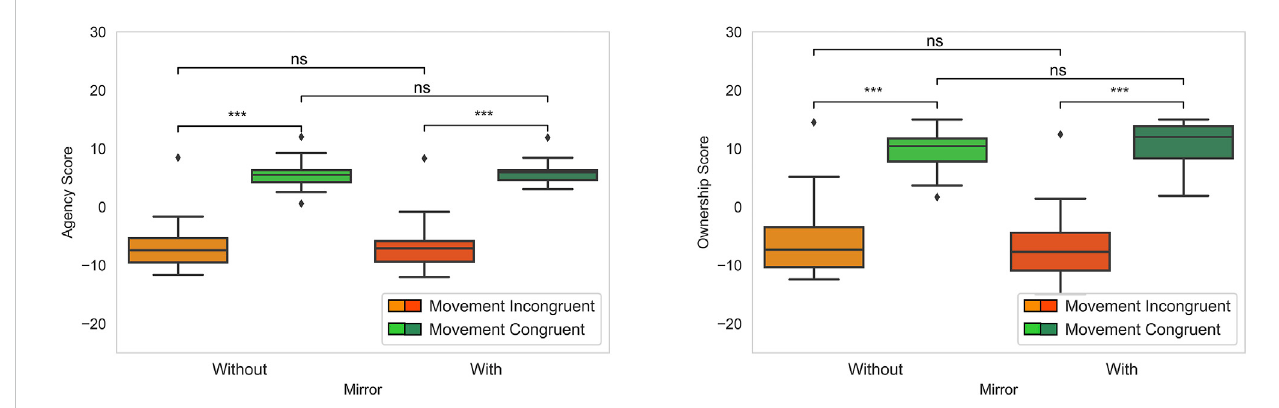
FIGURE 2 Preliminary study: Agency (left) and ownership (right) scores under